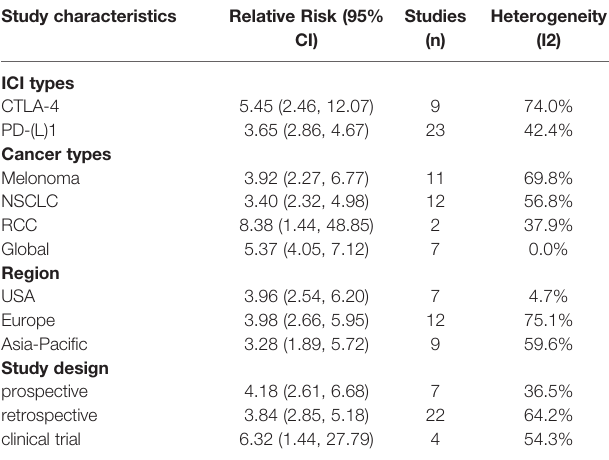
TABLE 2 | Subgroup analyses according to studies characteristics and methodology (end-point: ORR). Study characteristics